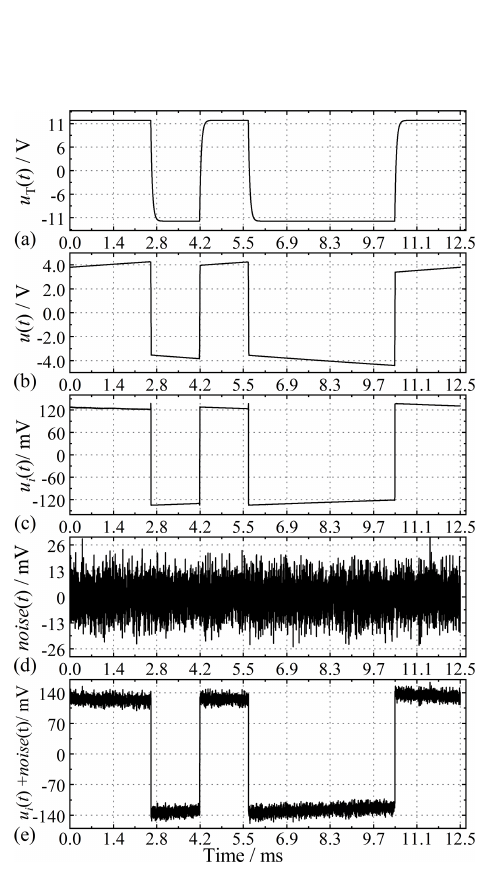
Figure 6. The time waves of (a) the applied voltage u T (t) , (b) the measured potential signal u(t) , (c) the voltage u i (t) at the sampling resistor, (d) noise ( t ), and (e) the synthetic signal ( u i (t) + noise (t) ).